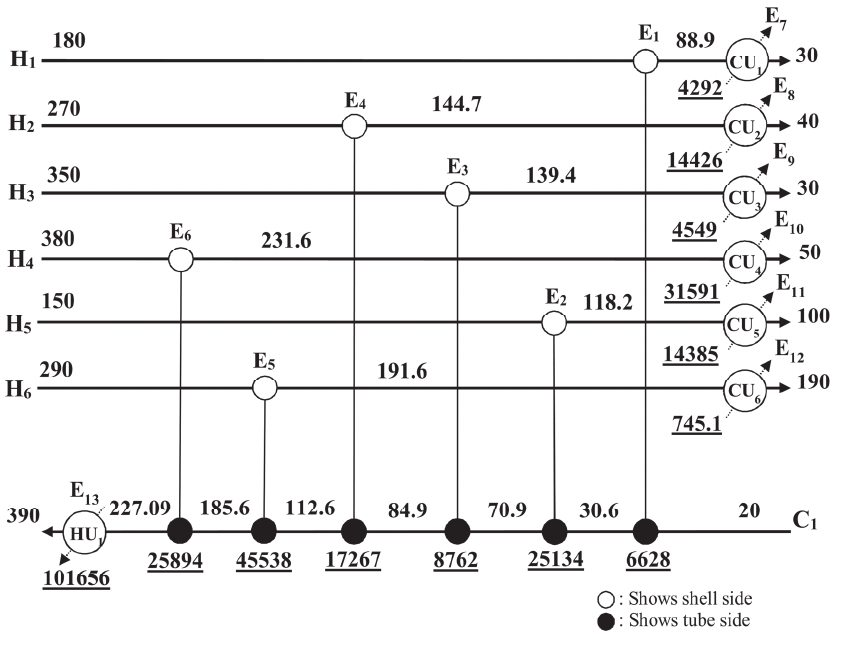
Figure 8 Fig. 8 – Initial HEN of case study two after increasing throughput